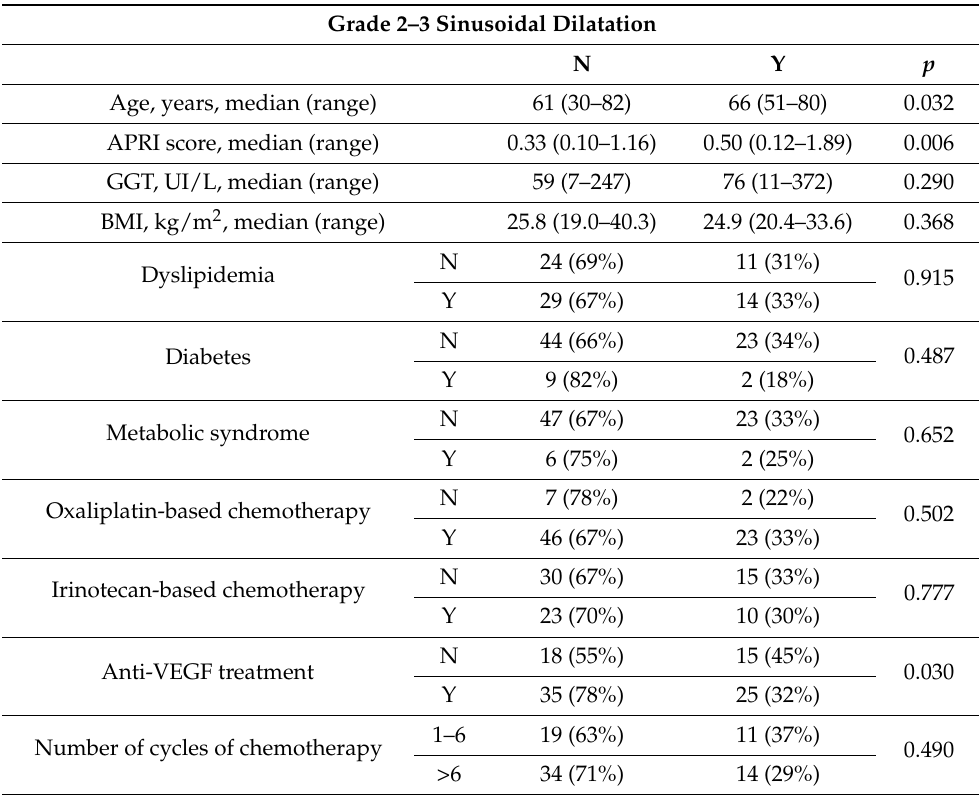
Table 2. Association between CALI and clinical and laboratory